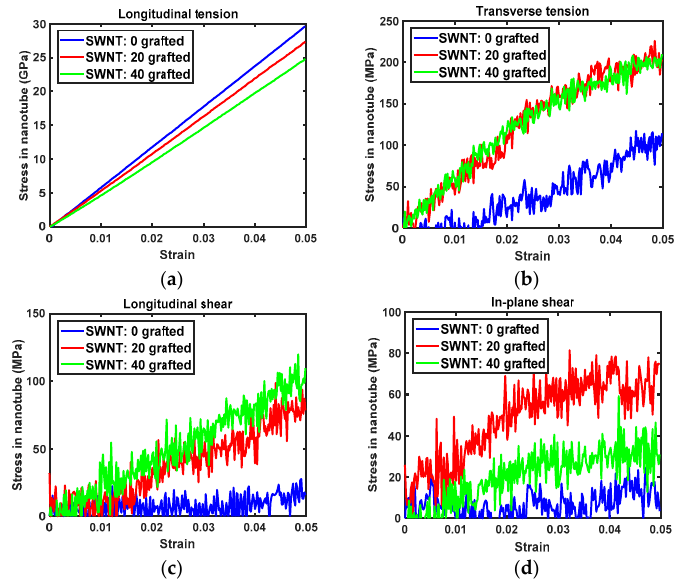
Figure 8. The evolution of stress of SWNTs in nanocomposites, specifically the ( a ) longitudinal tension, ( b ) transverse tension, ( c ) longitudinal shearing, and ( d ) in-plane shearing.